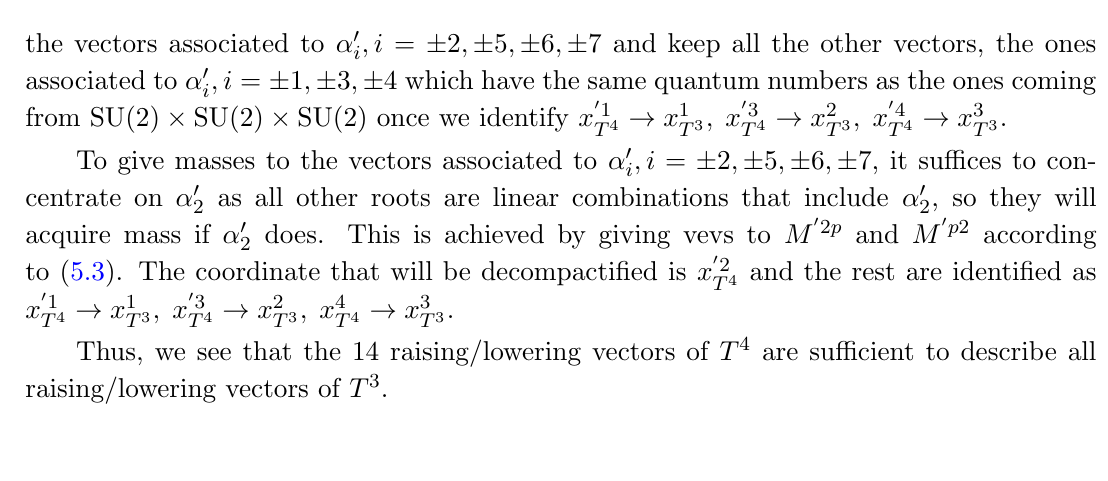
; i = (cid:6) 2 ; (cid:6) 5 ; (cid:6) 6 ; (cid:6) 7 and keep all the other vectors, the ones i ; i = (cid:6) 1 ; (cid:6) 3 ; (cid:6) 4 which have the same quantum numbers as the ones coming i